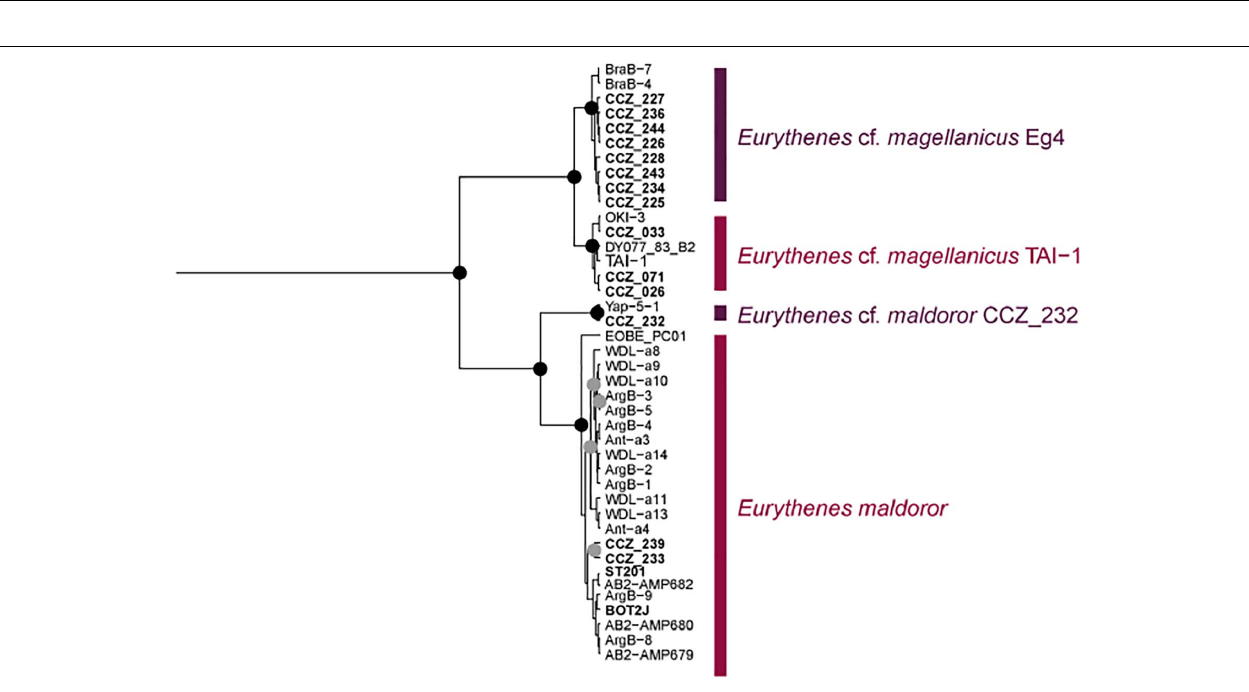
FIGURE 7 | Bayesian COI-only phylogenetic tree for species of Eurythenes distributed in the western CCZ. Genetic species are indicated on the right. Node posterior support values of 1.0 are indicated as black circles, and values ≥ 0.95 in gray circles. Sequences generated in this study are highlighted in bold, with western CCZ labels starting with “CCZ_”.